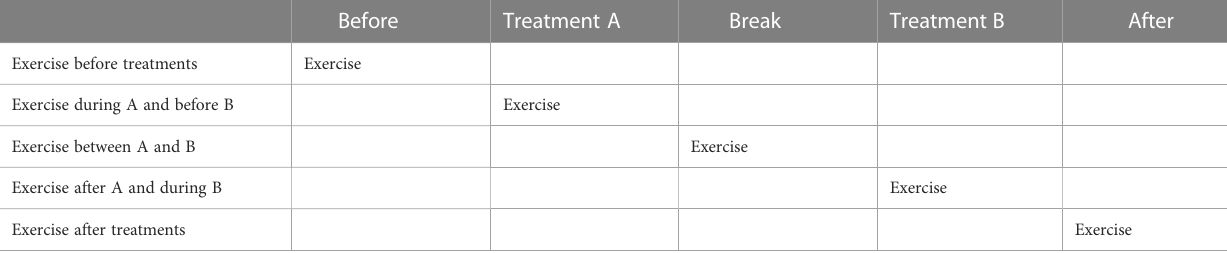
TABLE 4 Potential exercise treatment sequencing options given two (nonsurgical) sequential cancer